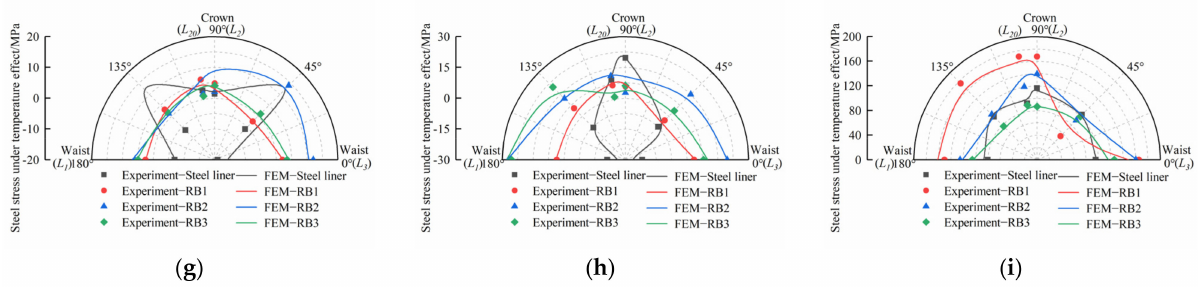
Figure 16. Thermal stress under finite element model and test model subjected to different temperature gradients: ( a ) A1; ( b ) A2; ( c ) A3; ( d ) B1; ( e )B2; ( f ) B3; ( g ) C1; ( h ) C2; ( i ) internal water pressure.